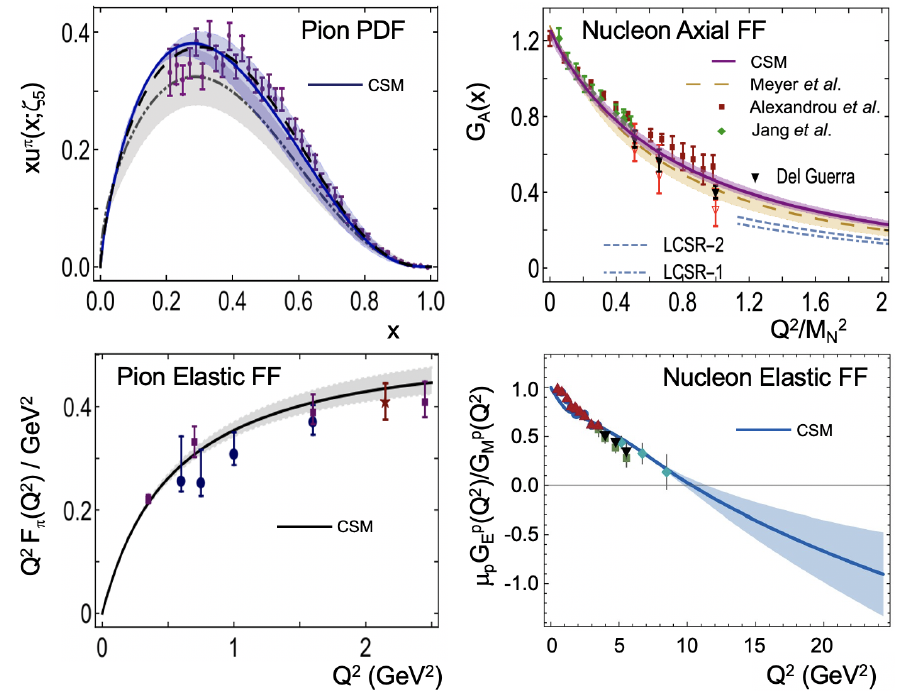
Figure 3. CSM predictions for observables of the structure for the ground state hadrons in comparison with experimental results (points with error bars) or comparable theory. ( Upper left )—pion valence quark PDF [100]; ( Upper right )—nucleon axial form factor G A [101]; ( Lower left )—pion elastic form factor [11]; and ( Lower right )—ratio of nucleon elastic electric and magnetic form factors [79]. Sources for comparison curves and points are listed in References